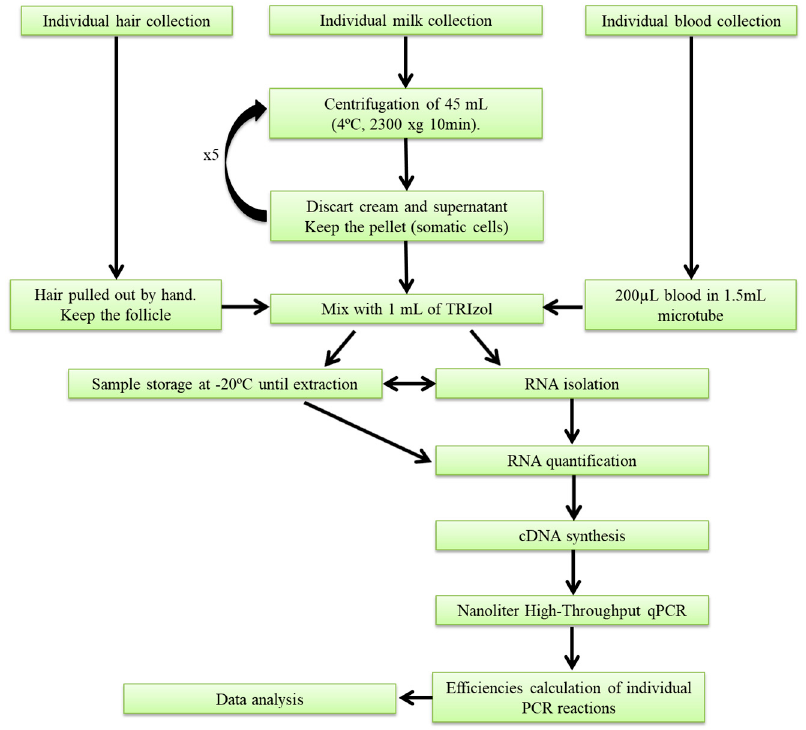
Figure 5. Workflow of matrix collection and gene-expression analysis.